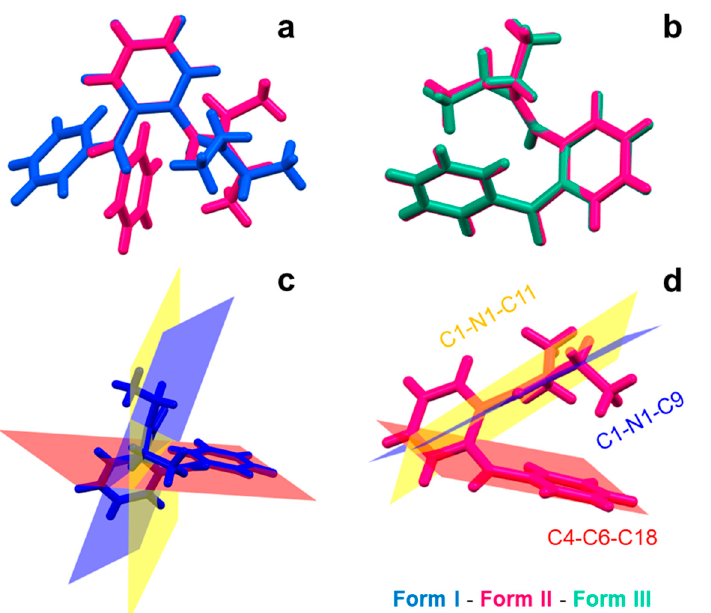
Figure 3. Molecule overlay between forms I and II ( a ), forms II and III ( b ) and the decrease of the angle between Ph1 and diethylamide groups for form I ( c ) in comparison with form II ( d ).